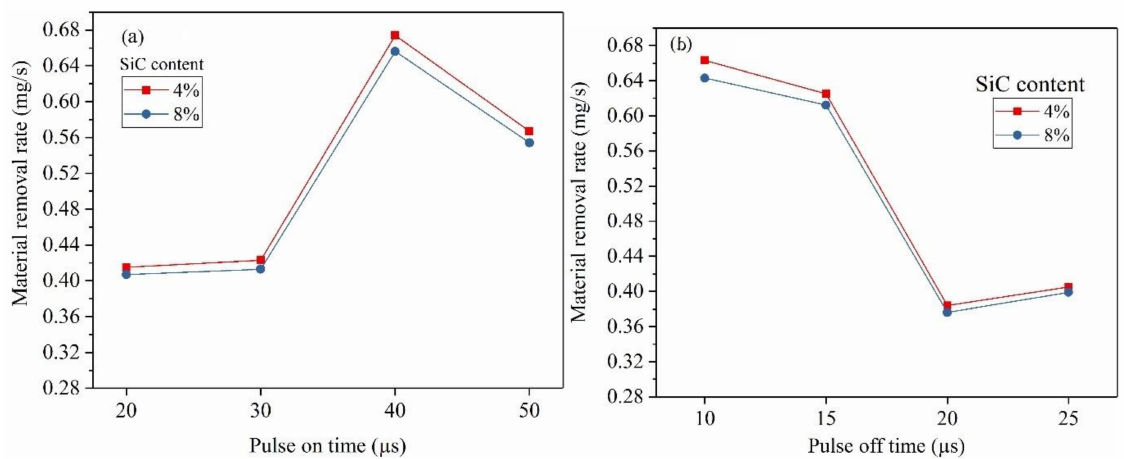
Figure 4. ( a ) The effect of Pulse-on time on MRR. ( b ) The effect of Pulse-off time on MRR.